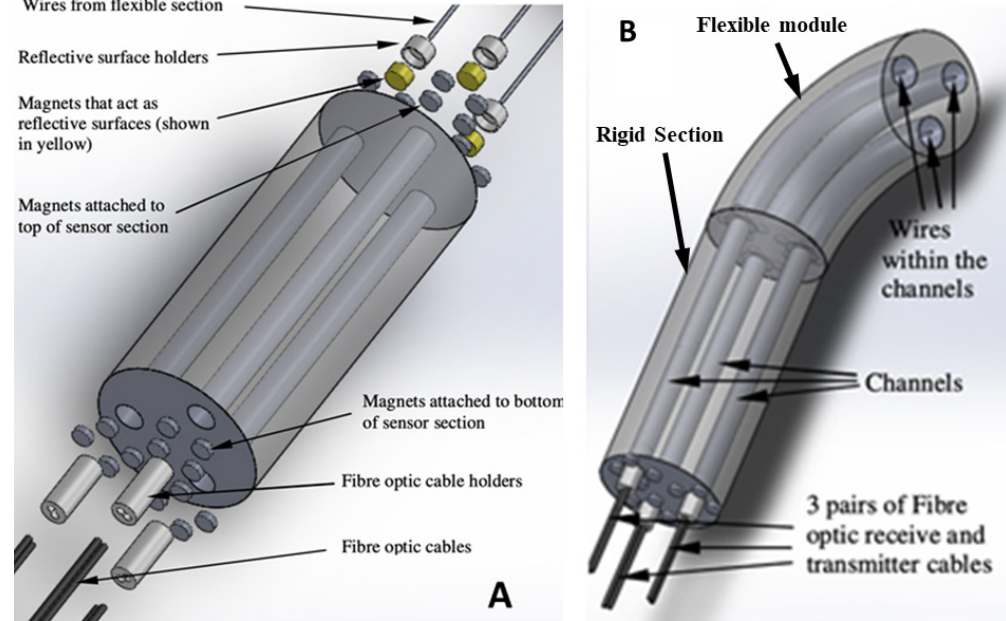
Figure 9. Constituent parts of the test system. ( A ) The rigid section with the integrated sensing elements; ( B ) Assembled system comprising the rigid sensor section and the flexible module [38].